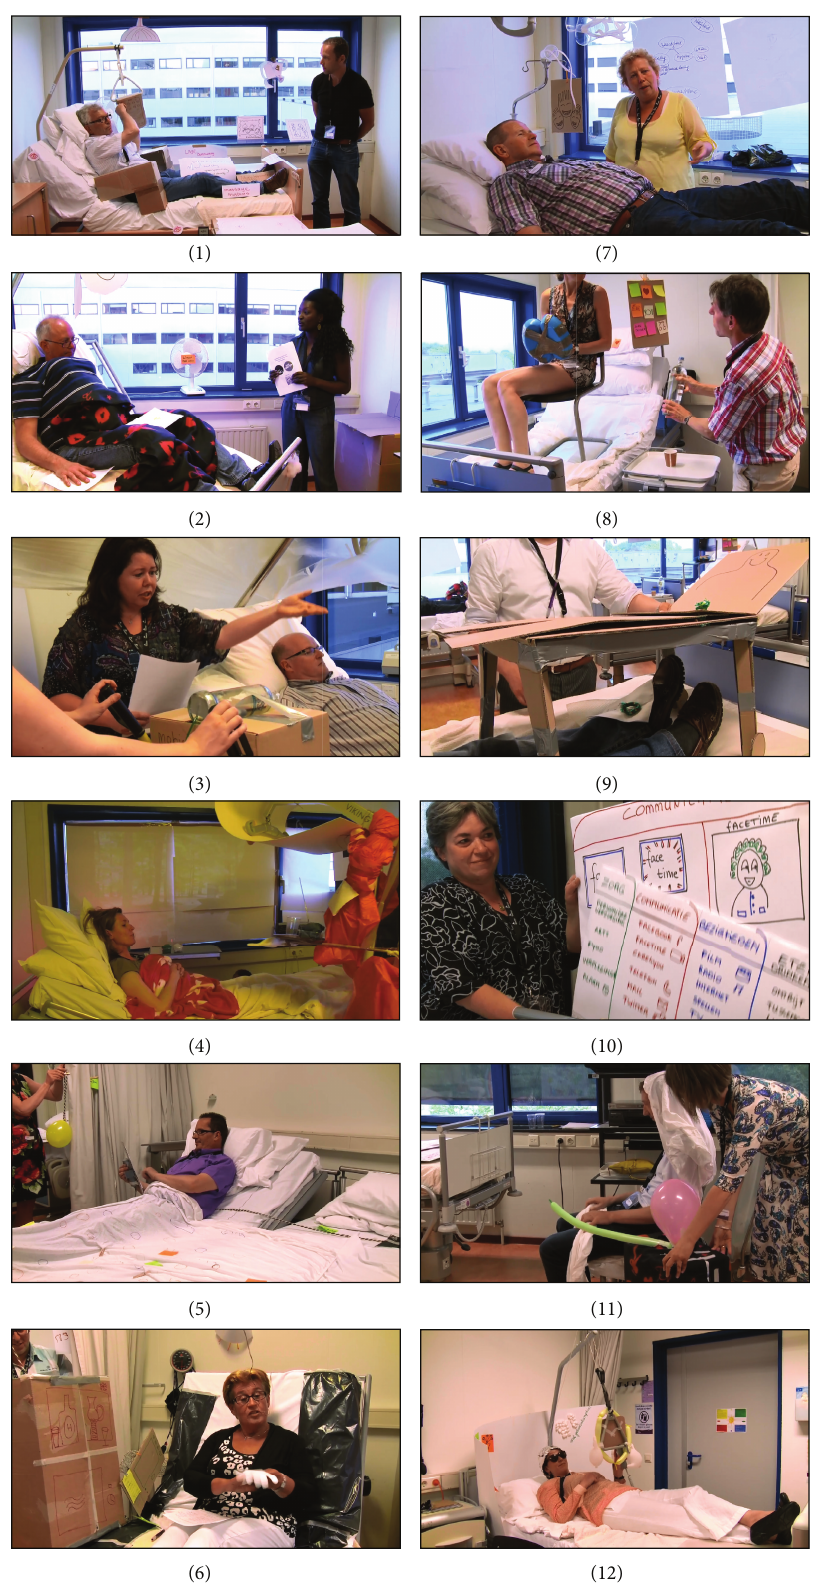
Figure 3: A composition of the twelve scenarios written and enacted by the